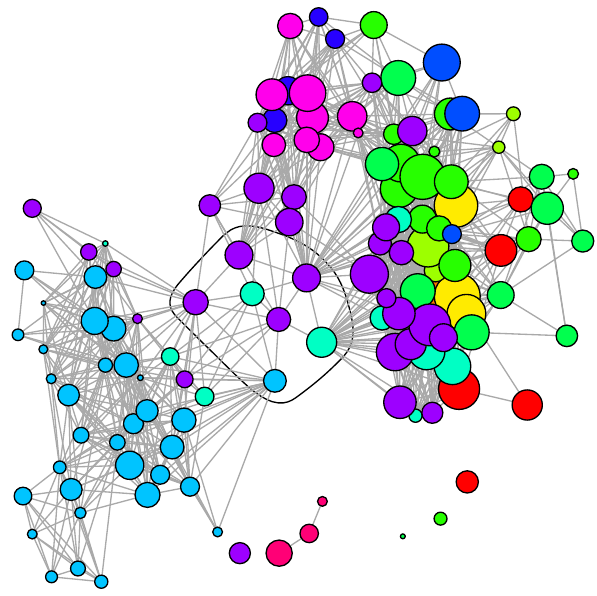
Figure 7. Graph representation of the streamflow network. The ver- tices were arranged by the algorithm of Kamada and Kawai (1989). The colours represent the WSC designated subregion as in Fig. 2. The stations inside the black circle are a subset of the stations hav- ing a high value of